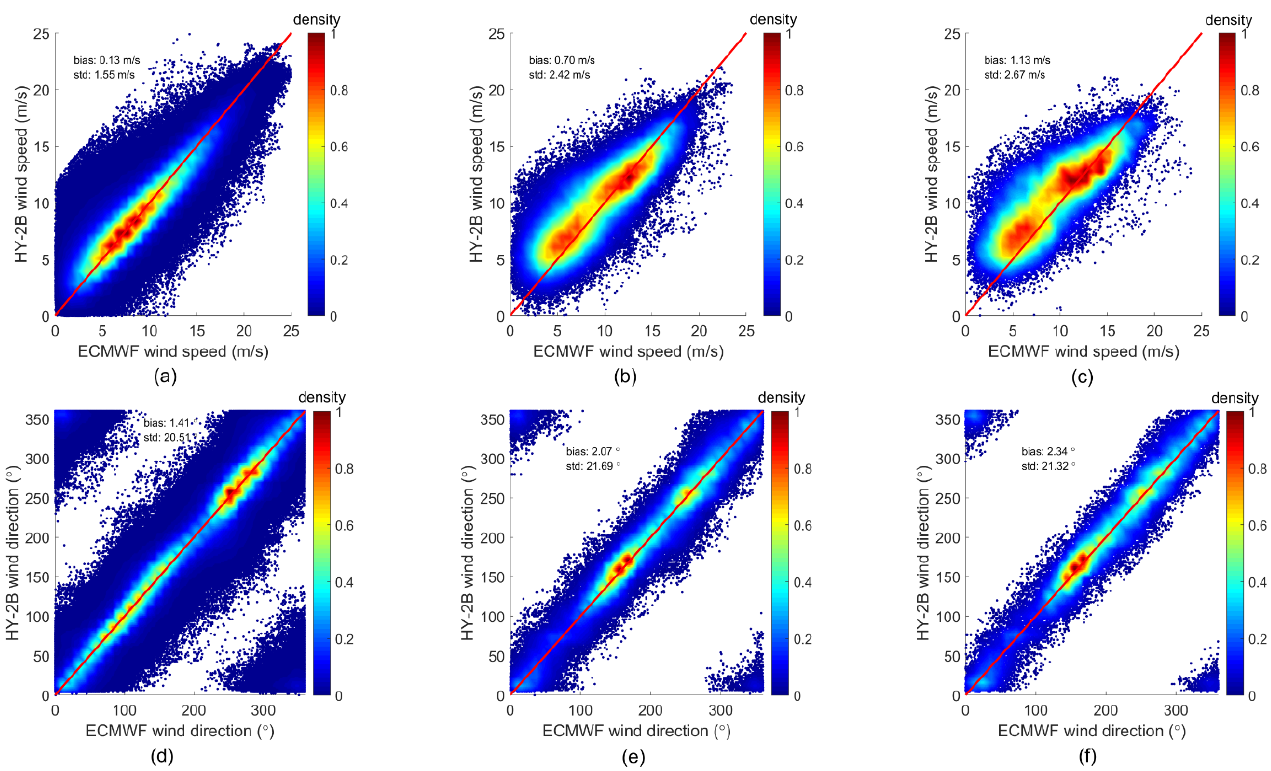
Figure 11. The density scatterplots of HY-2B wind retrievals versus the collocated ECMWF ERA5 wind vectors in three different rain regimes. ( a ) Wind speed retrievals under light rain (GPM rain rate below 4 mm/h); ( b ) wind speed retrievals under moderate rain (GPM rain rate above 4 and below 8 mm/h); ( c ) wind speed retrievals under heavy rain (GPM rain rate larger than 8 mm/h); ( d ) wind direction retrievals under light rain; ( e ) wind direction retrievals under moderate rain; ( f ) wind speed retrievals under heavy rain.